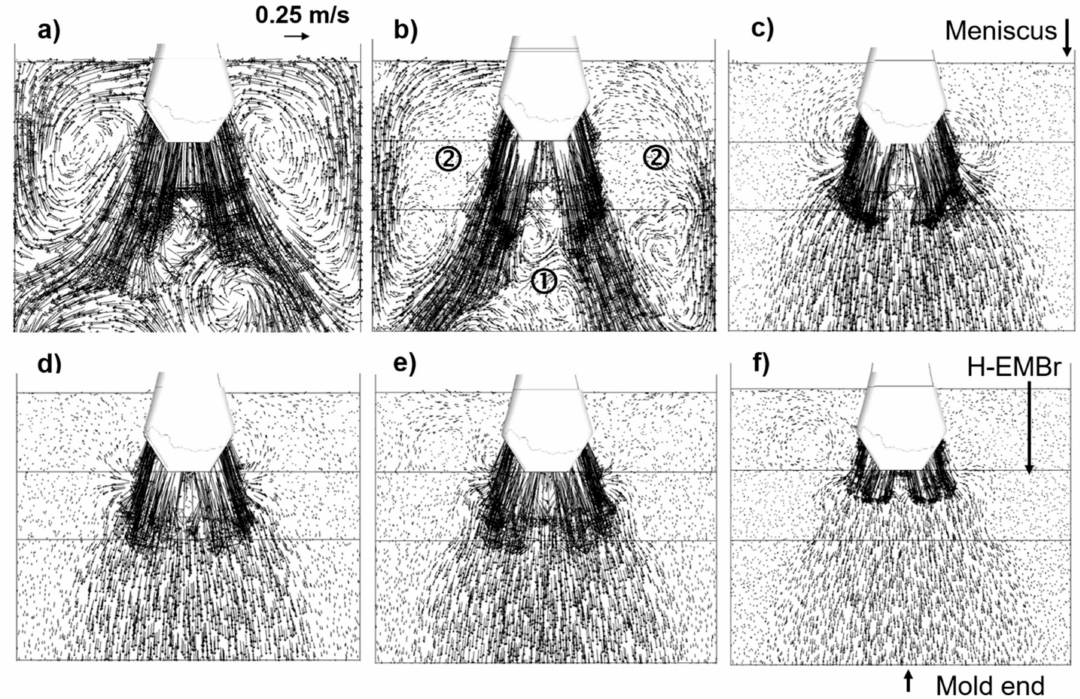
Figure 6. Velocity vectors at the central symmetrical plane of the mold with di ff erent intensities of H-EMBr, ( a ) 0, ( b ) 0.1, ( c ) 0.2, ( d ) 0.3, ( e ) 0.4 and ( f ) 0.5